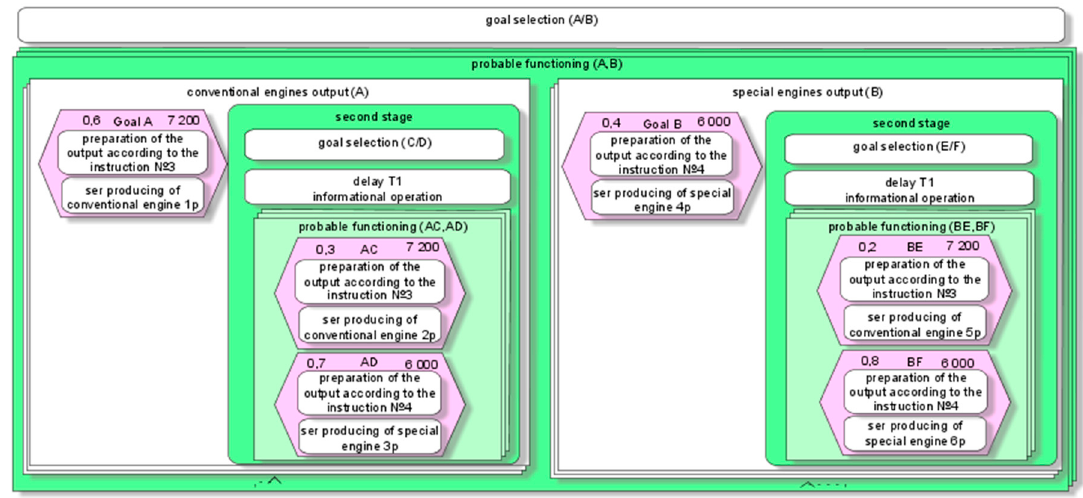
Figure 9. Diagrammatic ARIS model version 2 to estimate dynamic capability indicators.